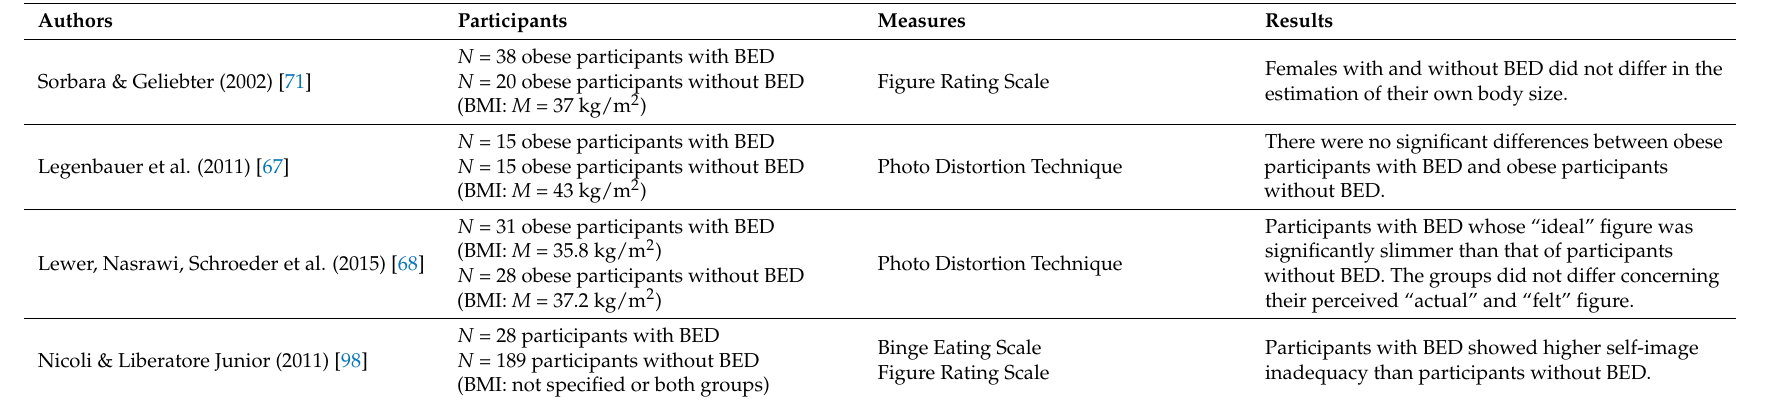
Table 4. Studies of misperception of body